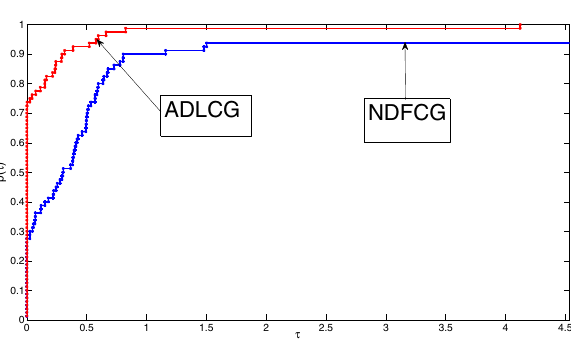
Fig. 1 Performance profile for number of iterations